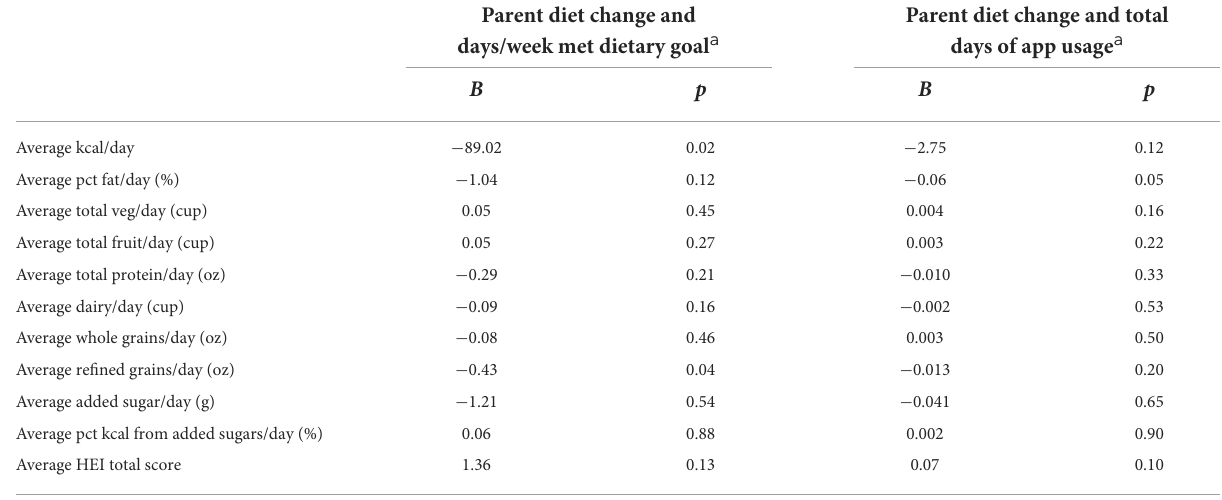
TABLE 3 Associations between parent dietary adherence and program engagement and dietary component changes. Parent diet change and Parent diet change and total days/week met dietary goal a days of app usage a